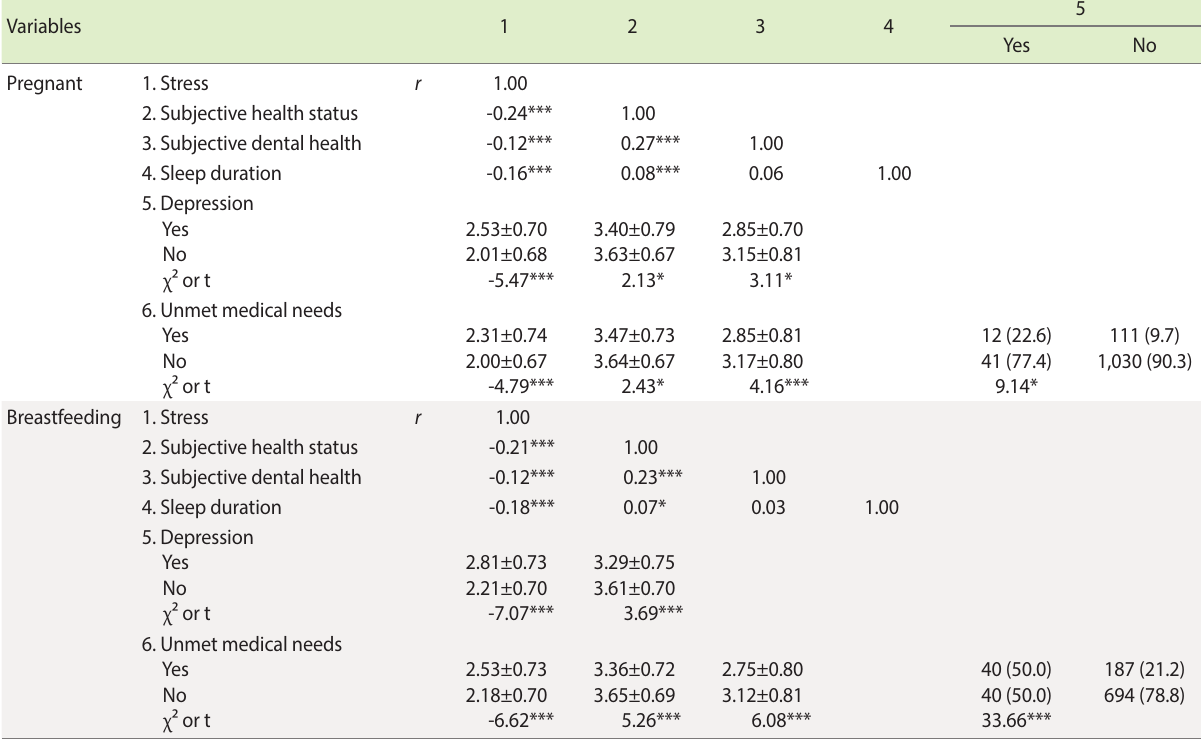
Table 2. Relationships among variables